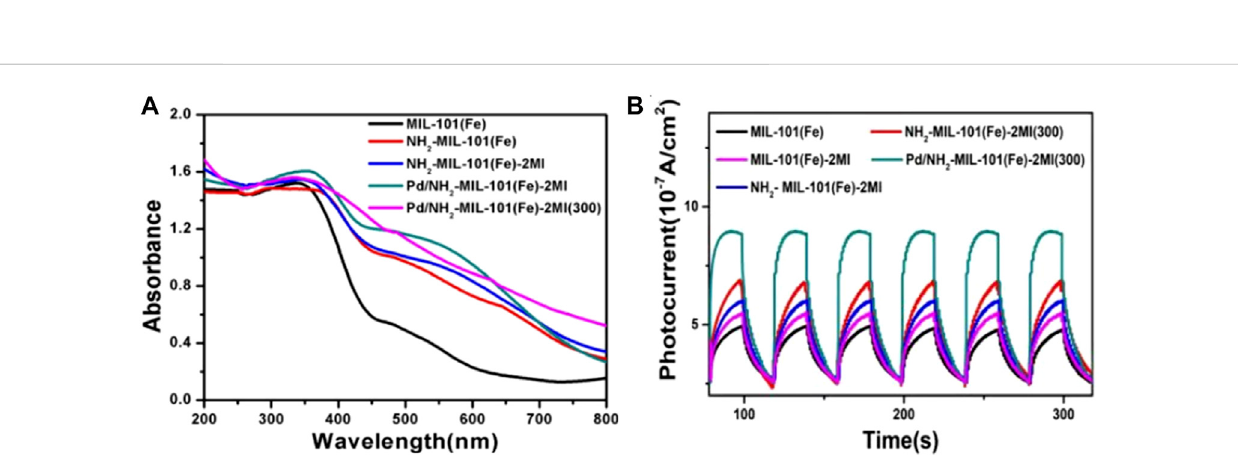
FIGURE 11 MOF and Pd/MOF catalysts. (A) UV-Vis diffuse re fl ectance spectra, and (B) photocurrent response. Reproduced with permission from reference (Cheng et al., 2020).